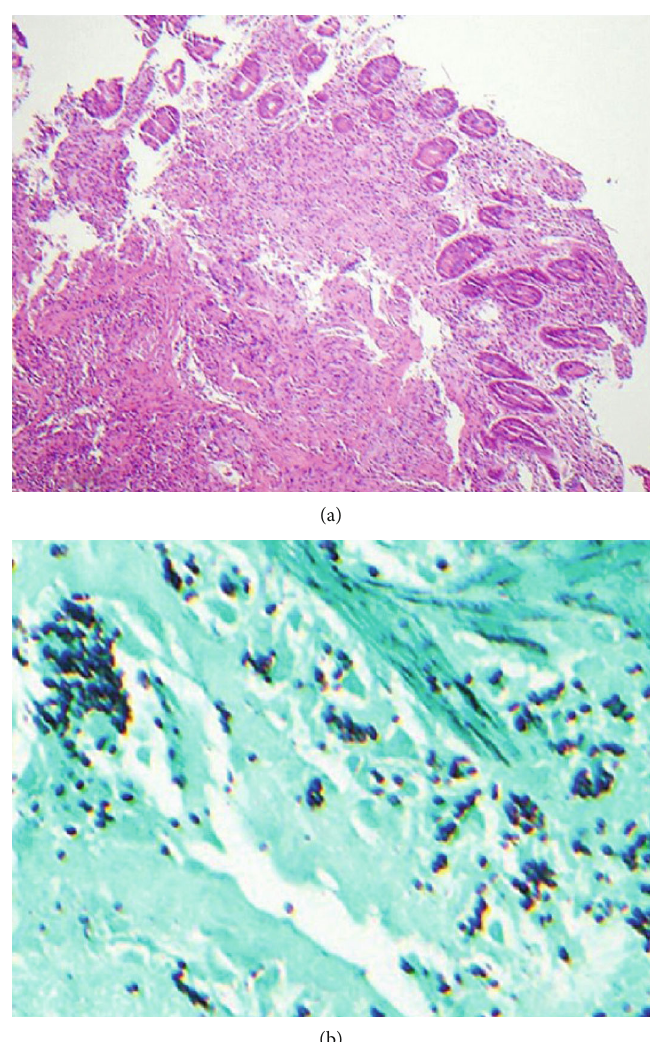
Figure 4: Hematoxylin and eosin (H&E) stain of a small intestinal biopsy specimen demonstrates granulomatous in fl ammation in an HIV patient diagnosed with disseminated Histoplasmosis (a). GMS stain reveals macrophages with intracellular fungal organisms (b). (Images obtained with permission from Spinner et al.